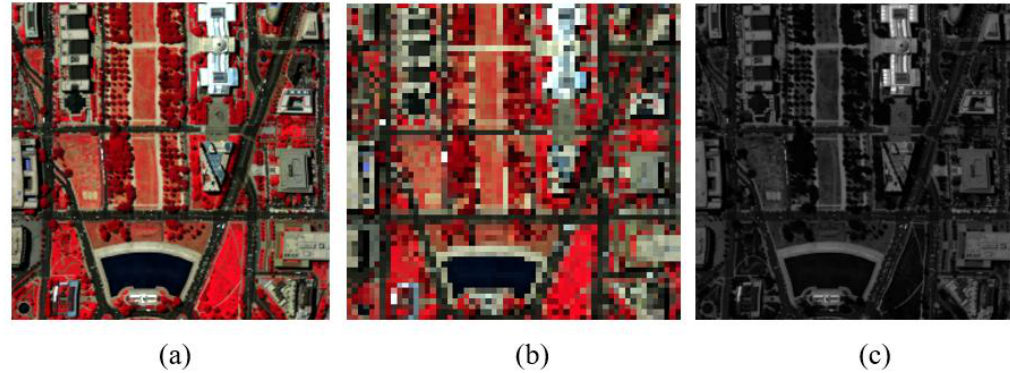
Figure 6. Washington, DC data set ( a ) RGB composites of Data set 1 (bands 65, 52, and 36 for red, green, and blue, respectively); ( b ) Simulated coarse image ( S = 2); ( c ) Panchromatic image.